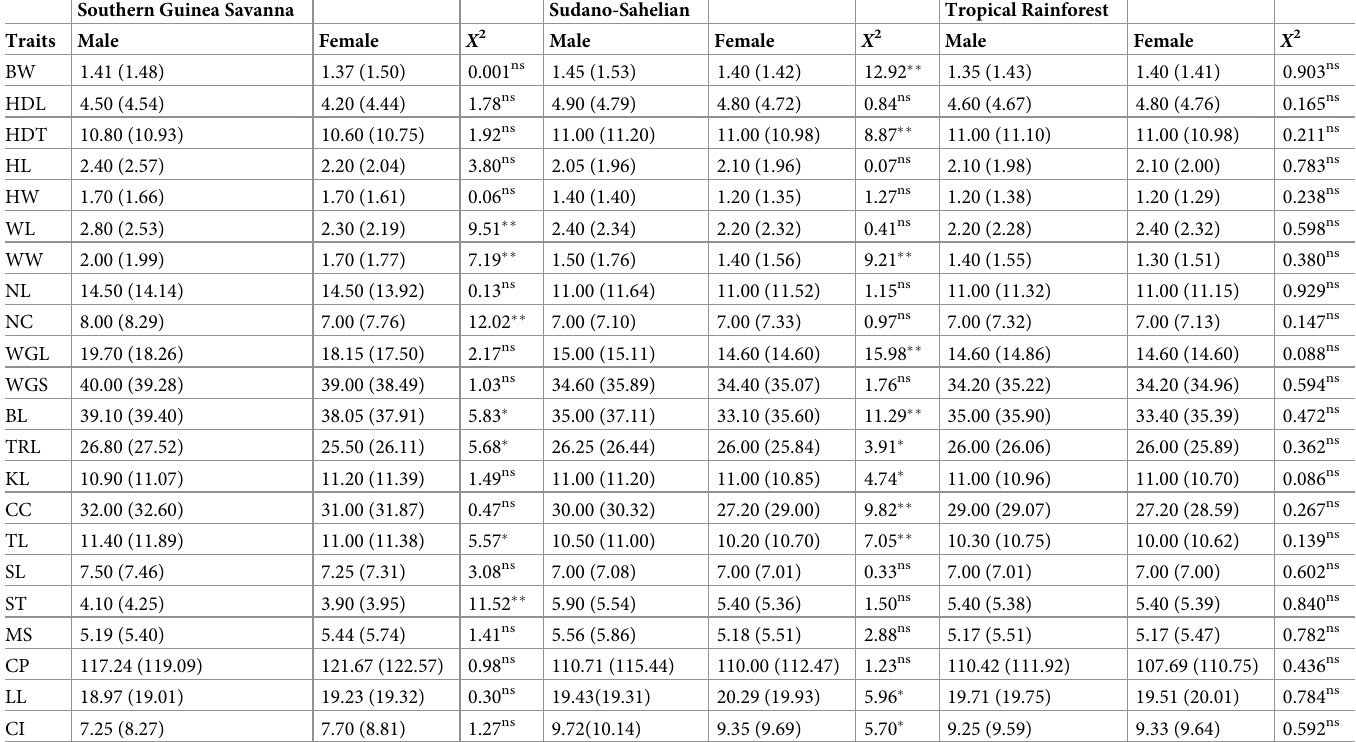
Table 5. Medians (means in parentheses) of biometric traits and morphological indices of indigenous helmeted Guinea fowls of sexes within agro-ecologies. Southern Guinea Savanna